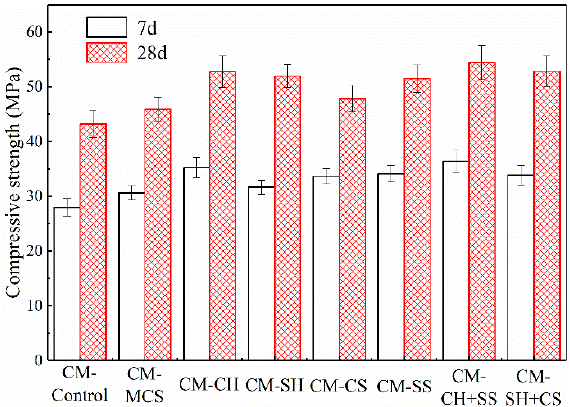
Figure 10. Compressive strength of cement